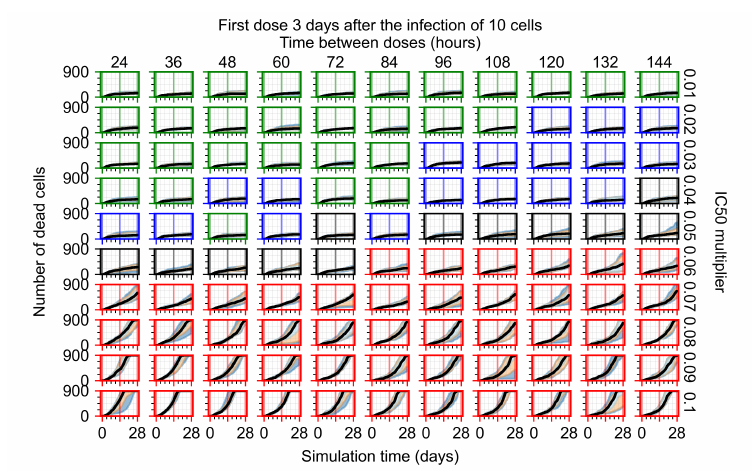
Figure A112. Dead